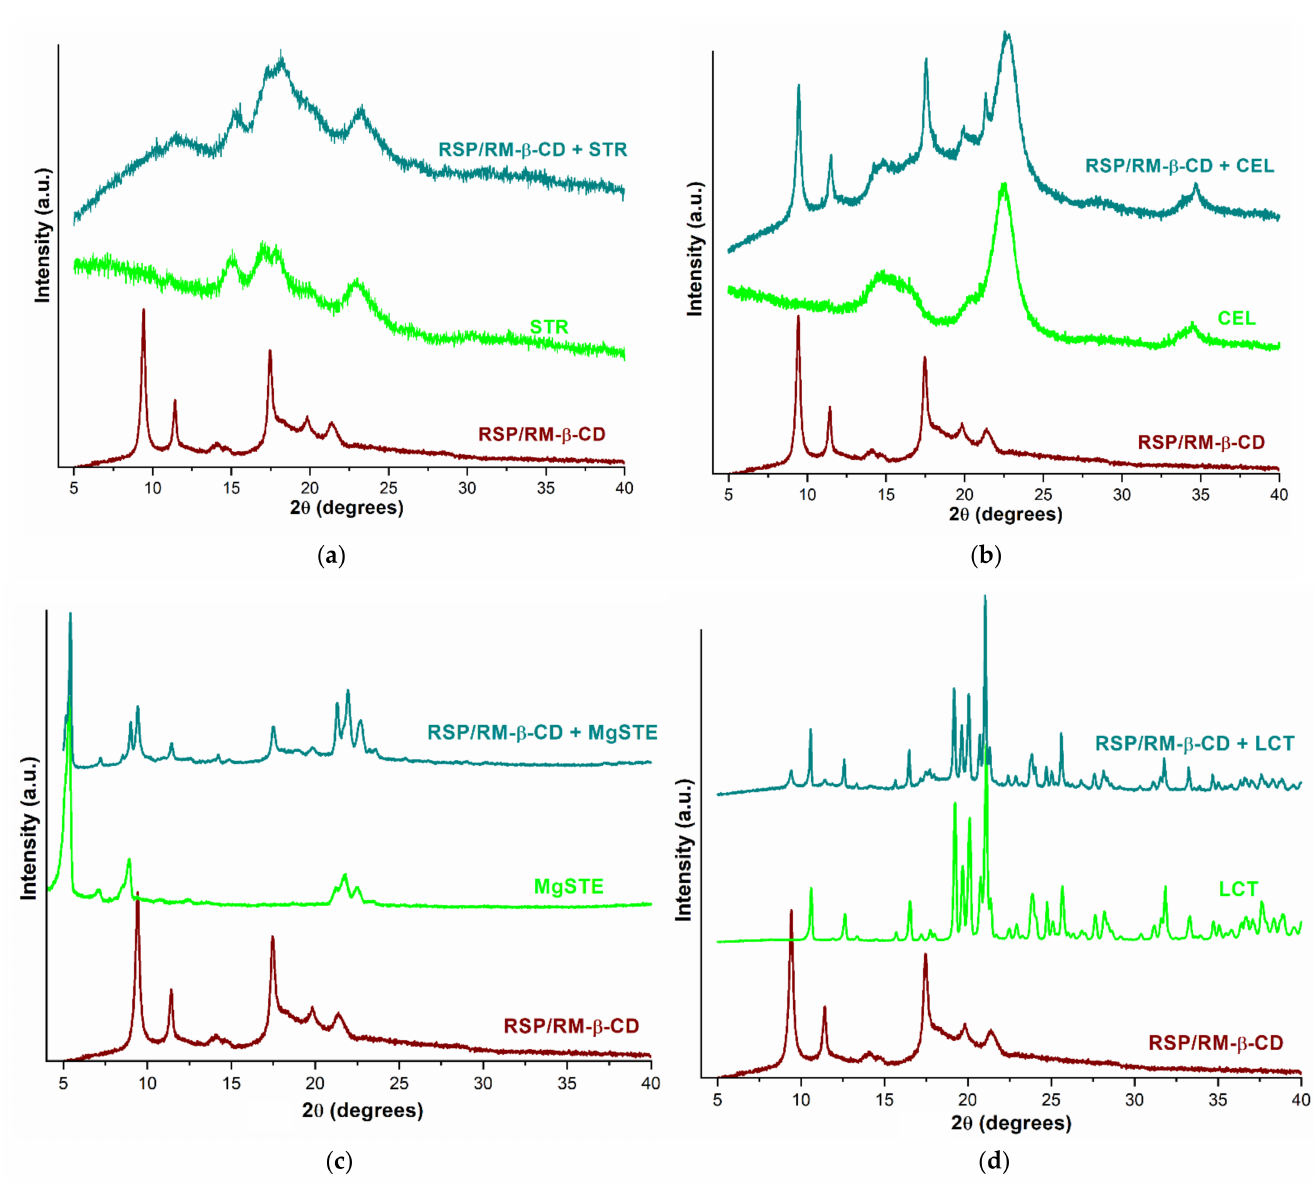
Figure 10. X-ray diffraction profiles of RSP/RM- β -CD inclusion complex, selected excipients, and their physical mixtures: starch (STR) ( a ); microcrystalline cellulose (CEL) ( b ); magnesium stearate (MgSTE) ( c ); lactose (LCT) ( d